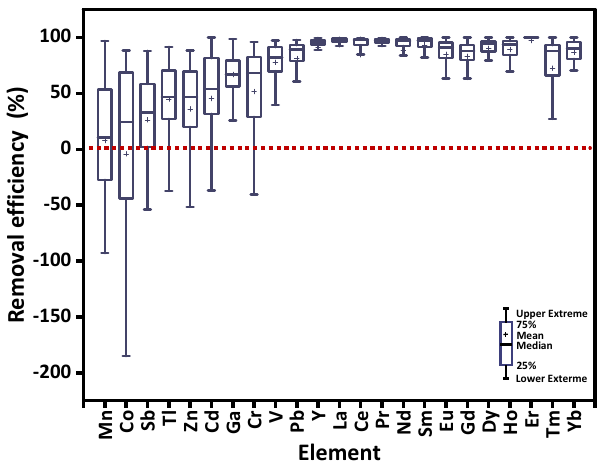
Figure 3. Overall removal efficiency of 23 elements at 7 WWTPs (box plots show the upper extreme, lower extreme, 25th and 75th percentile, mean and median values).